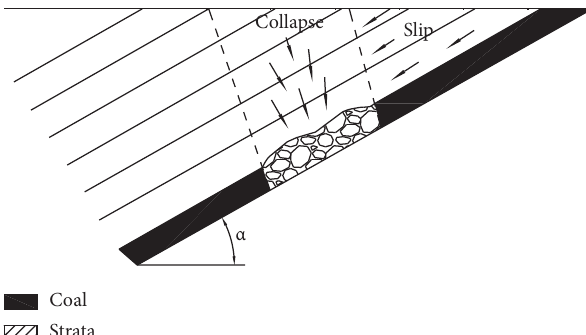
Figure 7: Movement form of inclined coal seam.